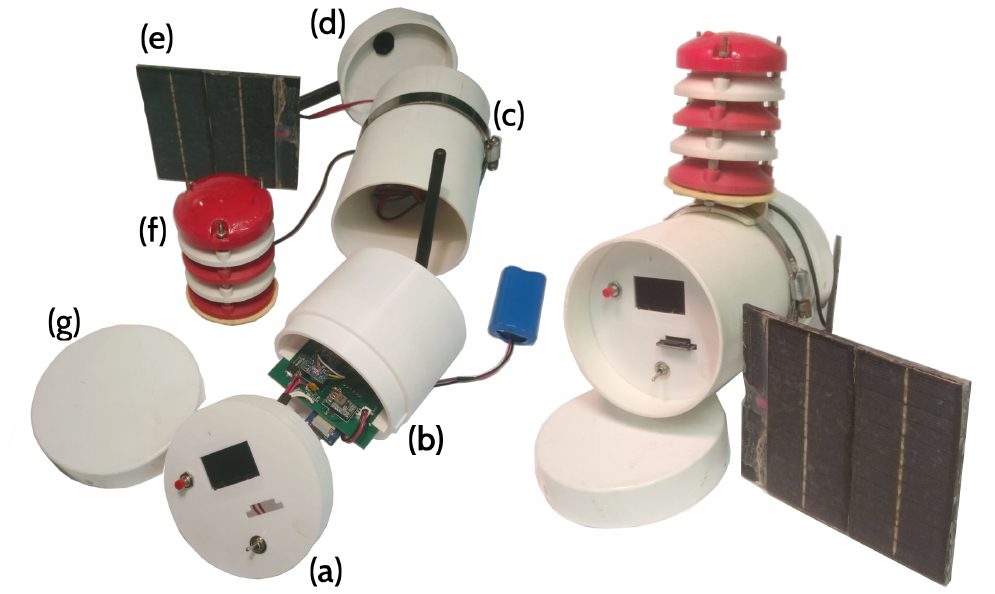
Figure A2. Exploded view of the housing components of the IoT device: ( a ) Front of the device containing monitor button, ON/OFF switch, SD and Oled display (3D-printed part). ( b ) support for datalogger board, batteries and wireless module. ( c ) Four-inch PVC pipe. ( d ) and ( g ) Back and front cover. ( e ) Solar panel. ( f ) Relative humidity and air temperature sensor shield. On the right-hand side, all assembled housing